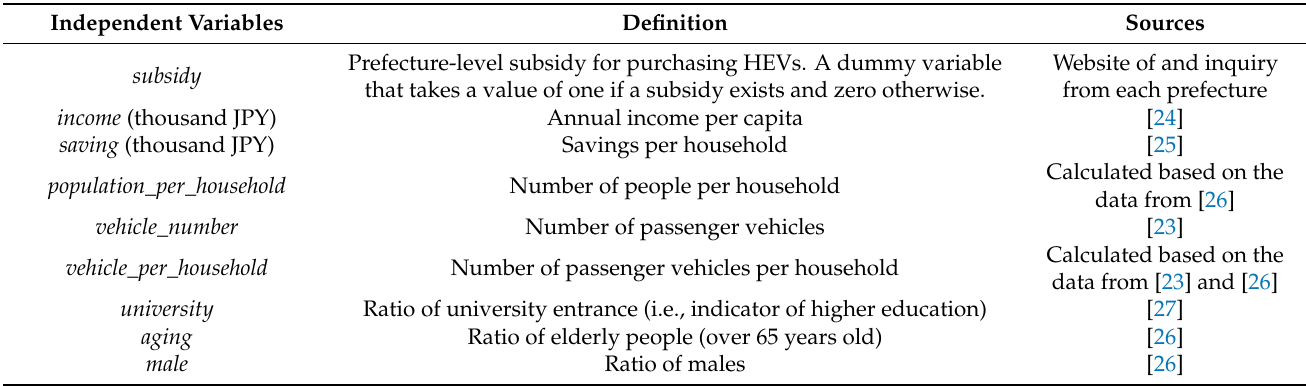
Table 1. Selection of independent variables and their data sources.